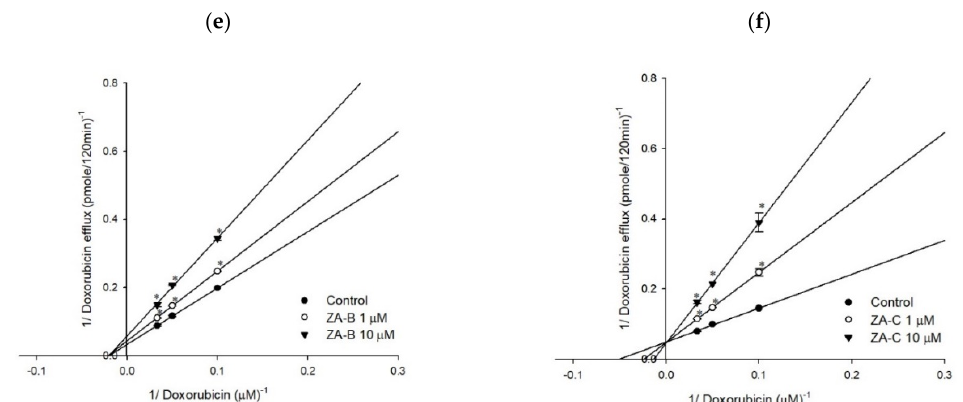
Figure 2. The Lineweaver–Burk plot analyses of ZA-A, ZA-B and ZA-C on the transport of rhodamine123 or doxorubicin in human P-gp. ( a ) ZA-A, ( b ) ZA-B and ( c ) ZA-C inhibited rhodamine 123 efflux via competitive, noncompetitive, and competitive mechanisms, respectively. ( d ) ZA-A, ( e ) ZA-B and ( f ) ZA-C inhibited doxorubicin efflux via competitive, noncompetitive and competitive mechanisms, respectively. * p < 0.05 compared with rhodamine123 or doxorubicin efflux without ZA-A, ZA-B or ZA-C treatment (control group). Data were presented as mean ± SE of at least three experiments, each in triplicate.